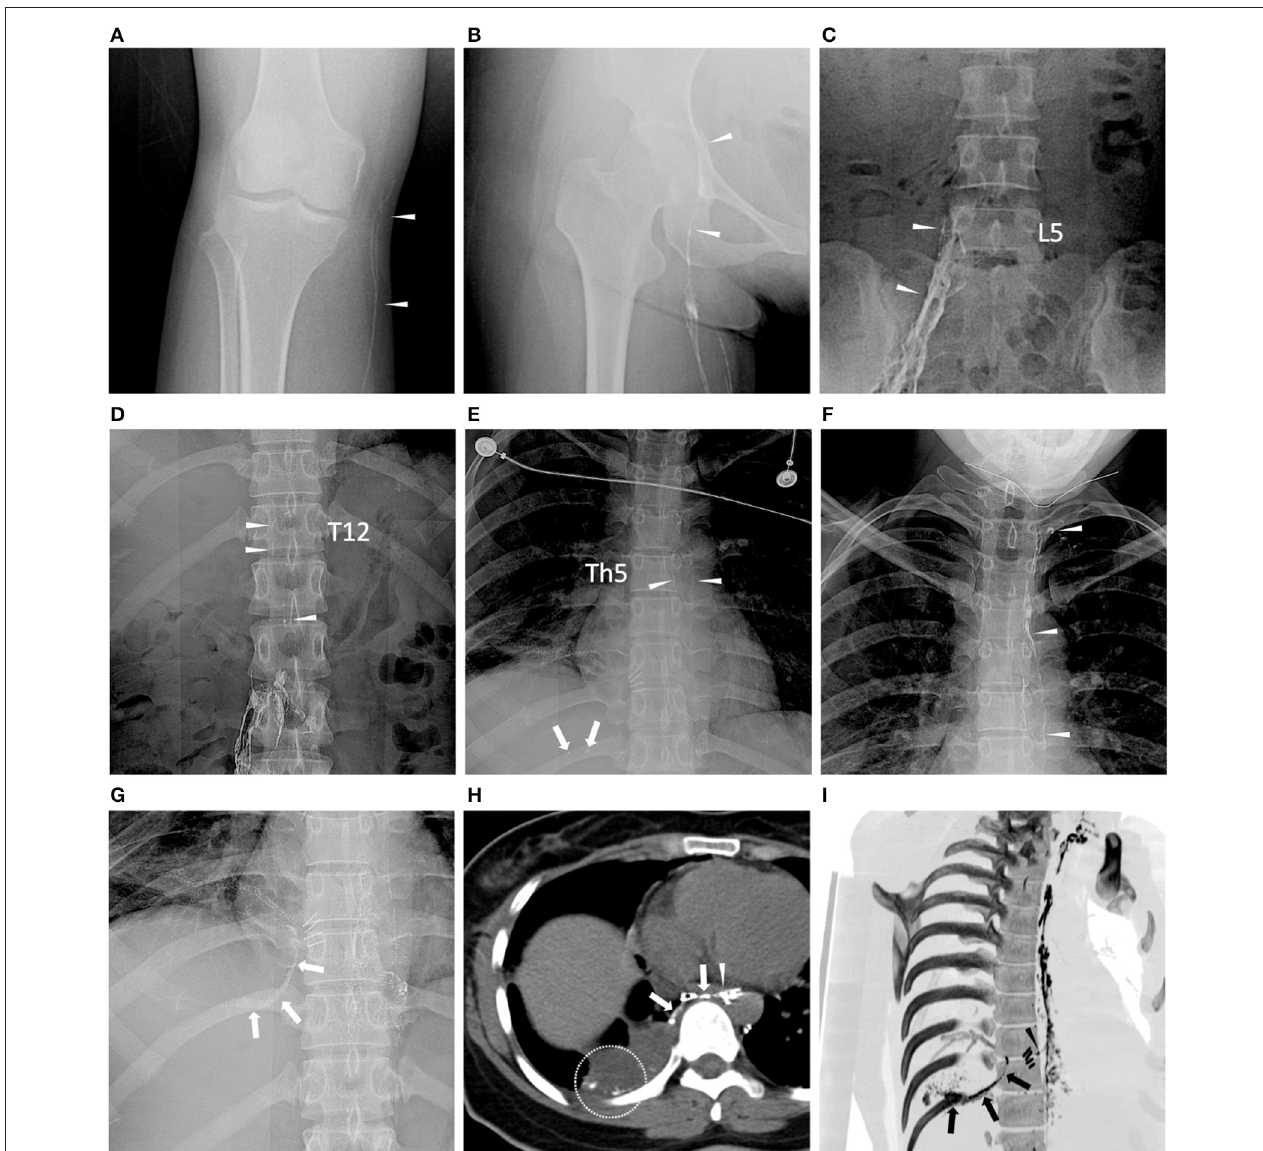
FIGURE 2 | Dynamic opacification of lymphatic vessels in fluoroscopy and chest CT. Images were obtained from the same patient with non-small cell lung carcinoma ( Patient ID: 3 ). (A–F) 3, 9, 22, 45, 52, and 60min after ethiodized oil injection, respectively, lymphatic vessels (white arrowheads) at the level of knee joint space, upper femoral head, L5, Th12 and Th5 vertebrae, and left jugular venous angle were consecutively opacified and dotted ethiodized oil extravasation [ (E) white arrows) can be observed in the course. (G) After completing the ethiodized oil injection (28.0ml), fluoroscopy demonstrated more definite ethiodized oil extravasation (white arrows). (H) Following CT (axial image with 5mm thickness) after TL showed a rupture of the thoracic duct (white arrowhead) near the metal clips (*) and thread-like ethiodized oil extravasation (white arrows) can be observed, as well as the free ethiodized oil in the right pleural effusion (within the white circle). (I) Reconstructed oblique CT image with maximum Intensity projection (MIP) showed more intuitive opacification of the thoracic duct, leakage site (black arrowhead) near the metal clips, and the ethiodized oil extravasation in the right pleural cavity (black arrows). It indicated a possibility of iatrogenic damage to the thoracic duct in the